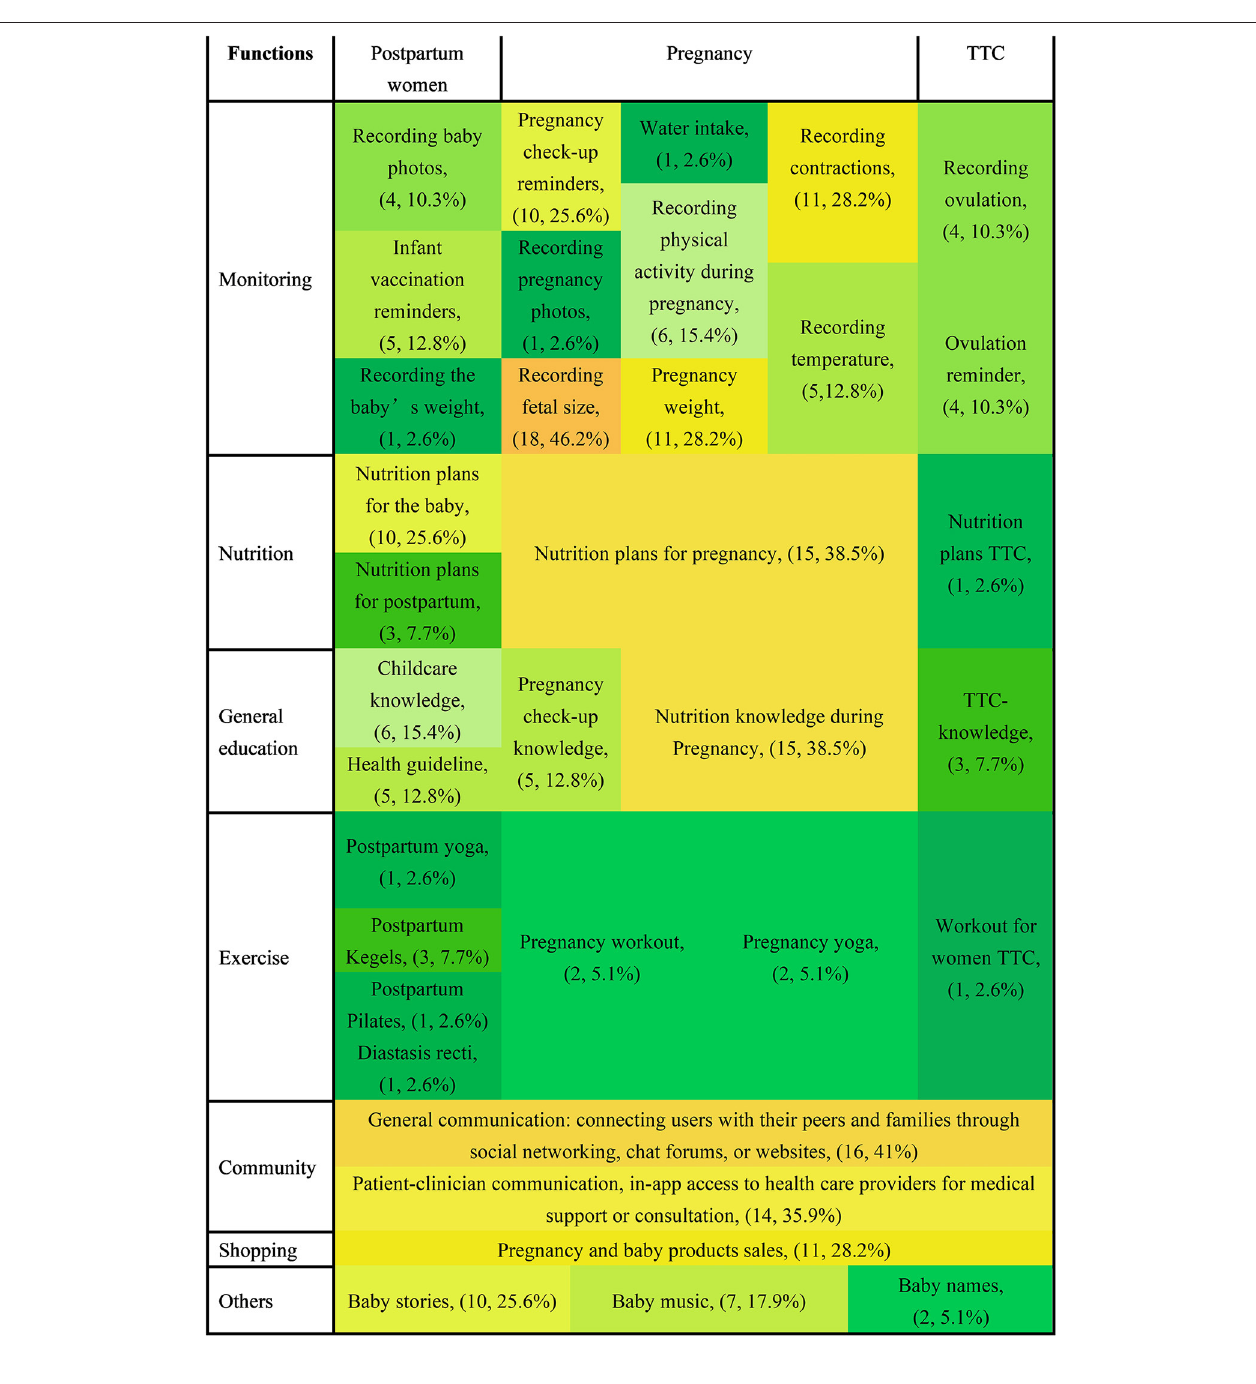
FIGURE 2 | Heat map of features of the 39 Chinese mobile apps for pregnancy to postnatal care. TTC, trying to conceive.